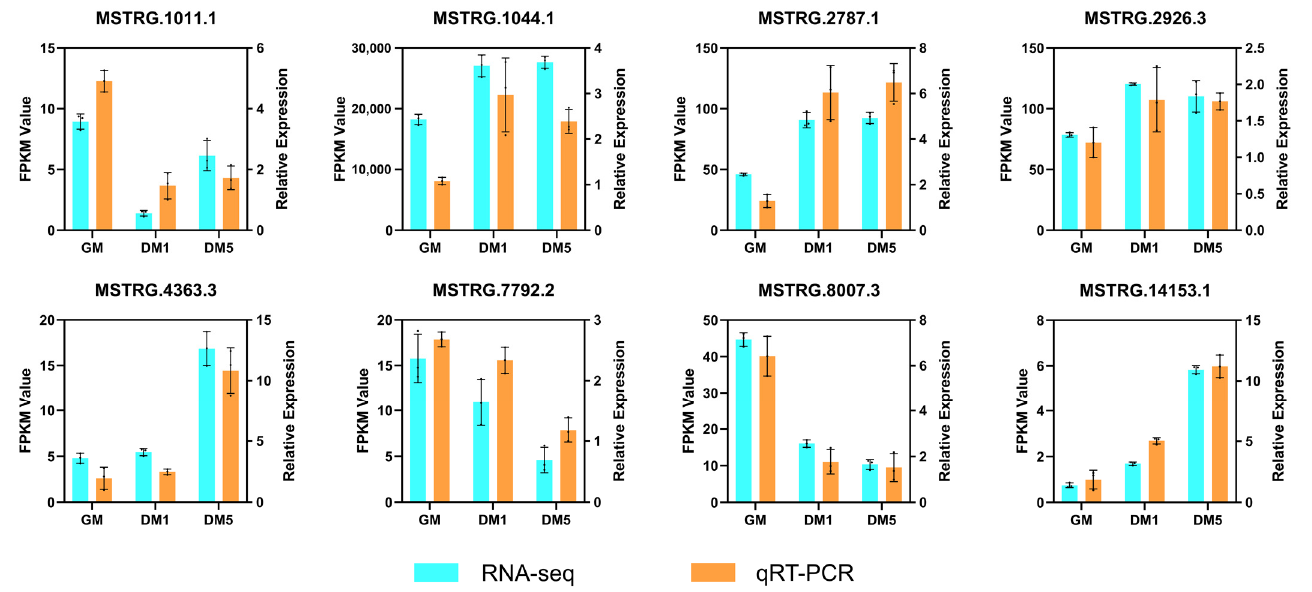
Figure 8. Validation of eight lncRNAs by qRT-PCR. Expression levels were measured by RT-qPCR, calculated by the 2- ∆∆ Ct, and normalized to GAPDH. Data are the mean ± SEM.